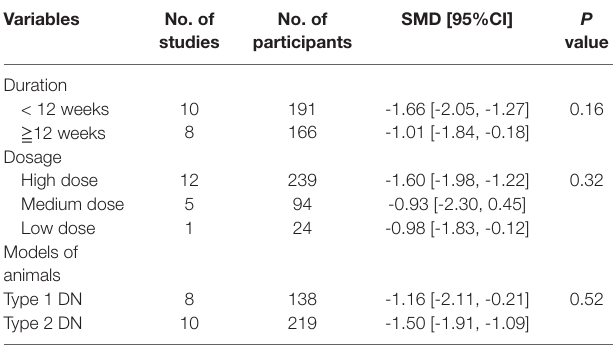
tABLe 5 | Subgroup analysis according to urine